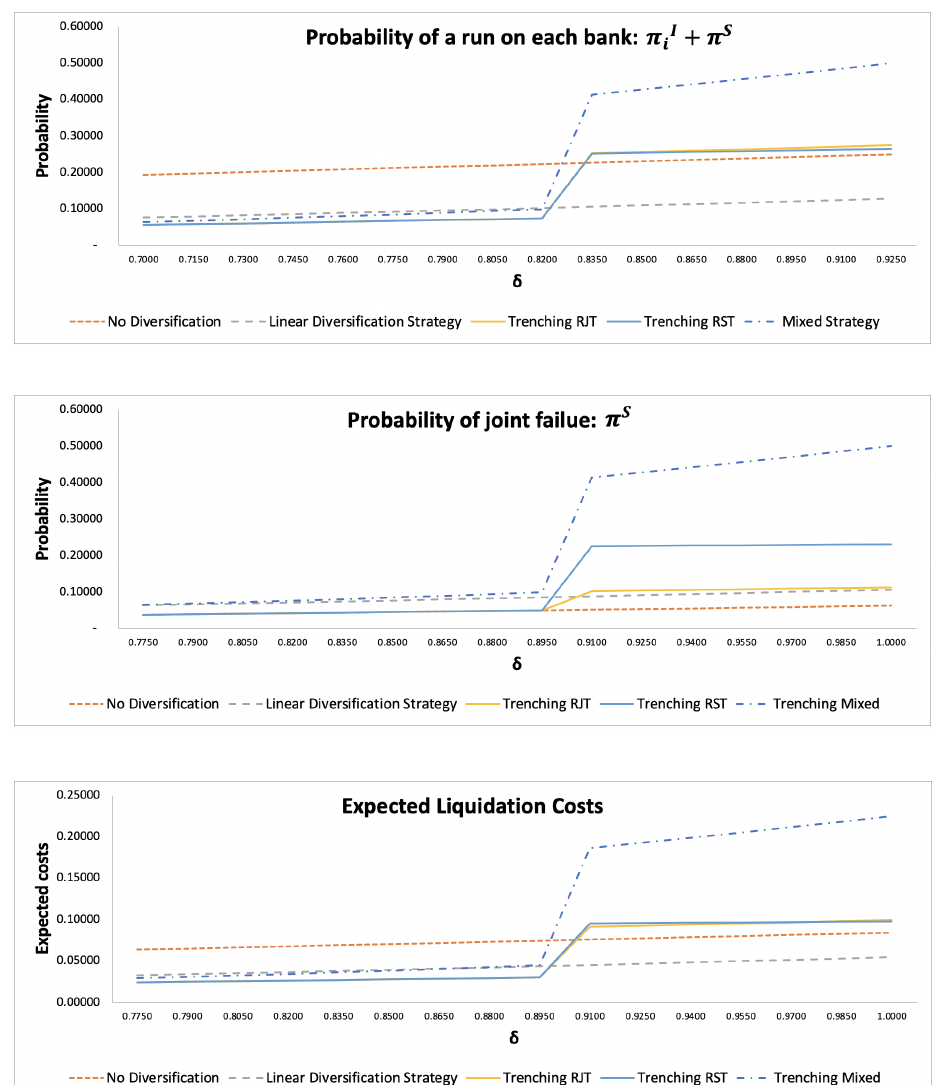
Figure 6. Diversification outcomes after a confidence